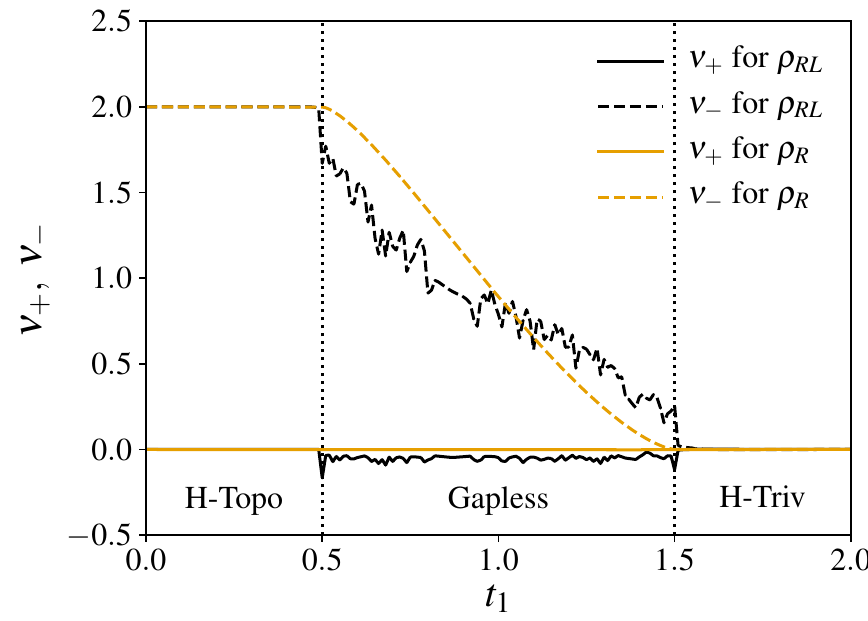
Figure 7: Topological invariants ν + and ν − of the biorthogonal and the right entan- glement Hamiltonian in the pseudo-Hermitian limit γ = 0 and µ = 0.5, as a function of the hopping t . We consider a system of size L = 401 and a subsystem of size 1 l = 40. The vertical dashed lines mark the PBC phase transitions. ν − is a good topo- logical invariant for both the biorthogonal density matrix ρ RL and the right density matrix ρ R in the two line gapped phases “H-Topo” and “H-Triv”. The results for ρ RL and ρ R exactly match in these two